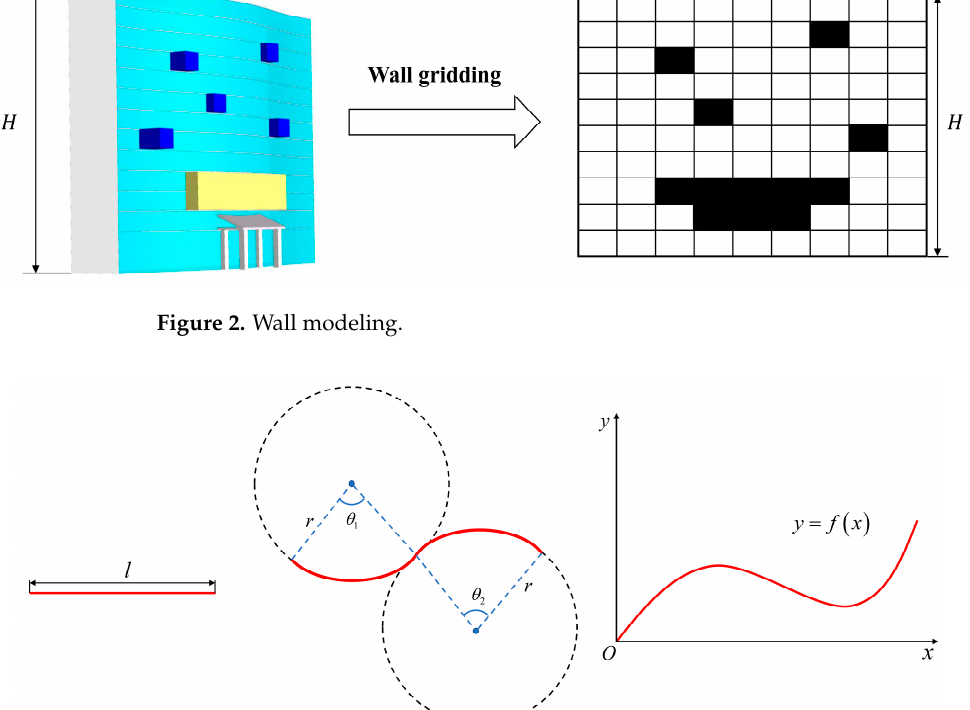
Figure 3. Wall length solution.